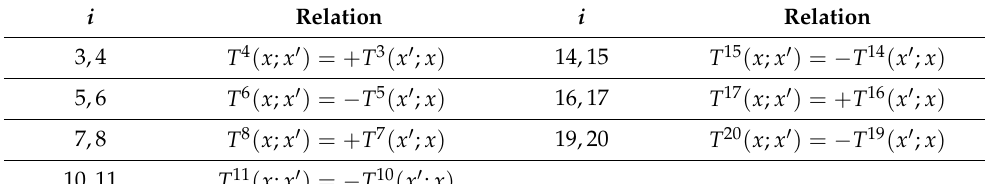
Table 2. Scalar coefficient functions in Expression (11), which are related by